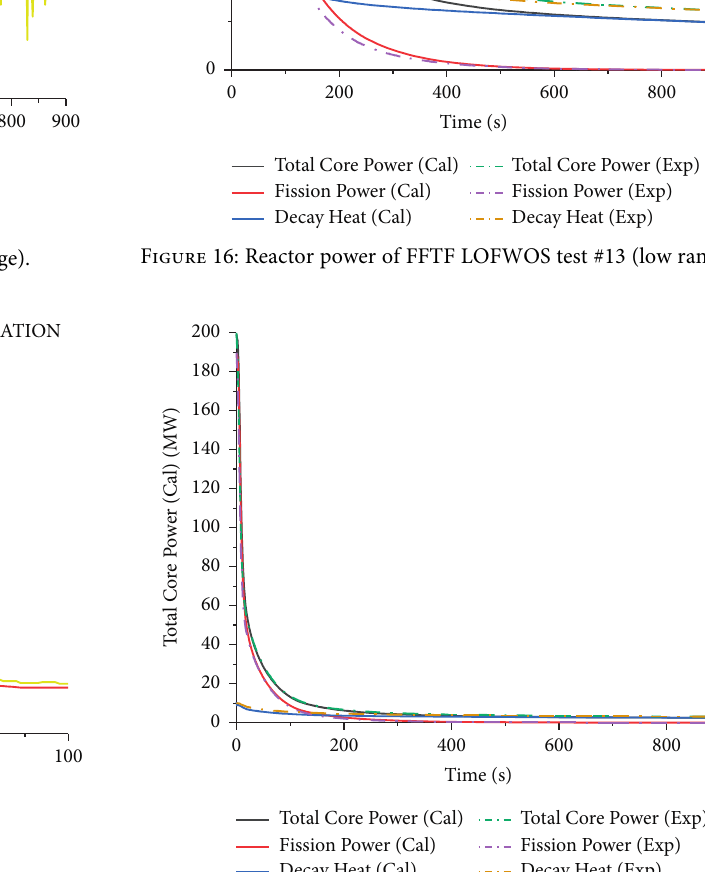
Figure 15: Mass flow rate in loop #1